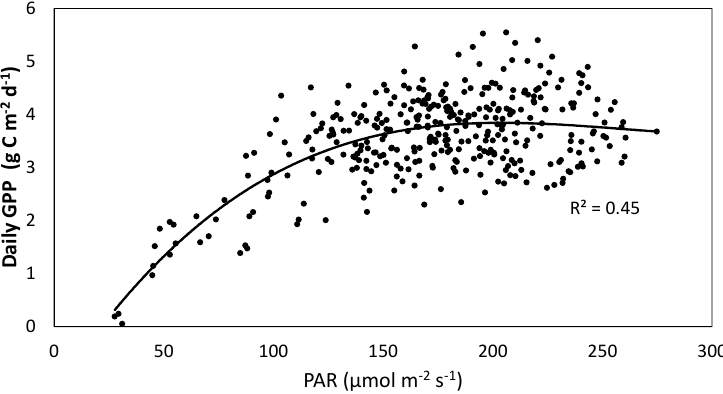
Figure 12. Relationship between daily GPP and daily average photosynthetic absorbed radiation (PAR) during daytime.